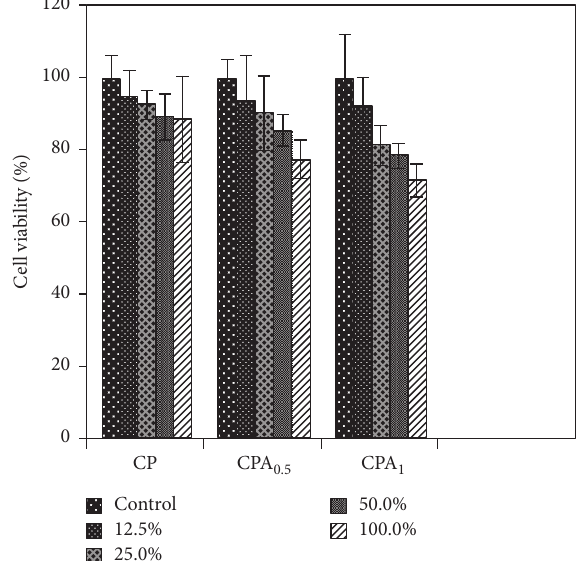
Figure 7: Toxicity of CP, CPA 0.5 , and CPA 1 using MTT